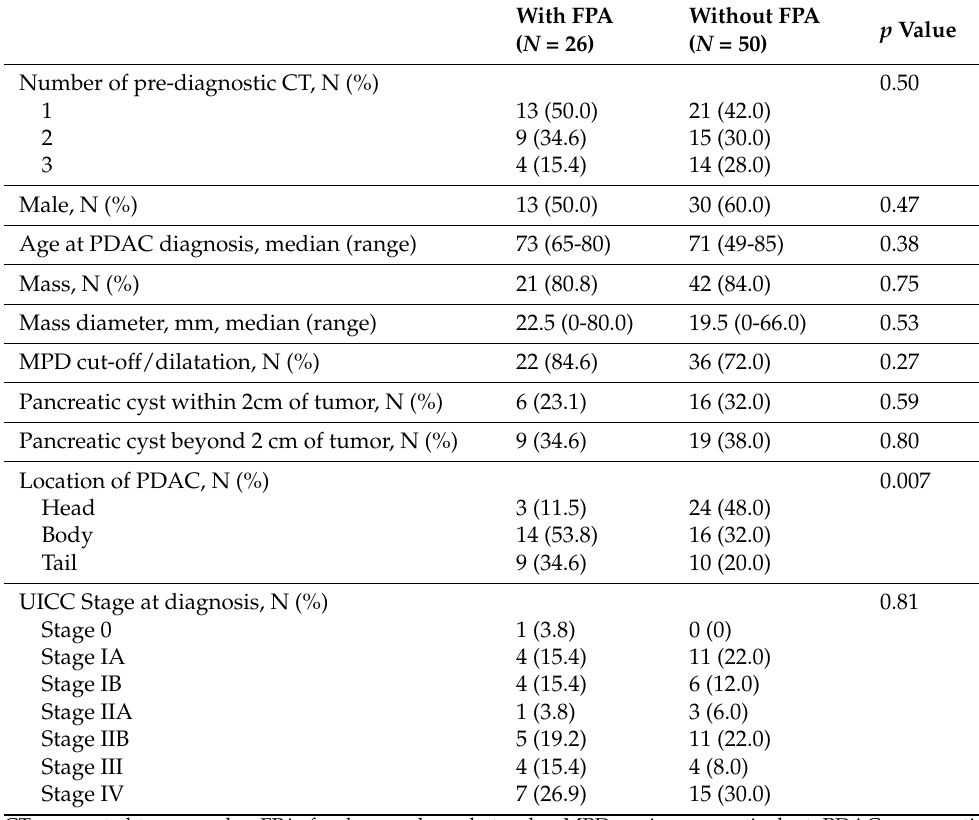
Table 4. Comparison of the cases presenting with FPA and those who did not on pre-diagnostic